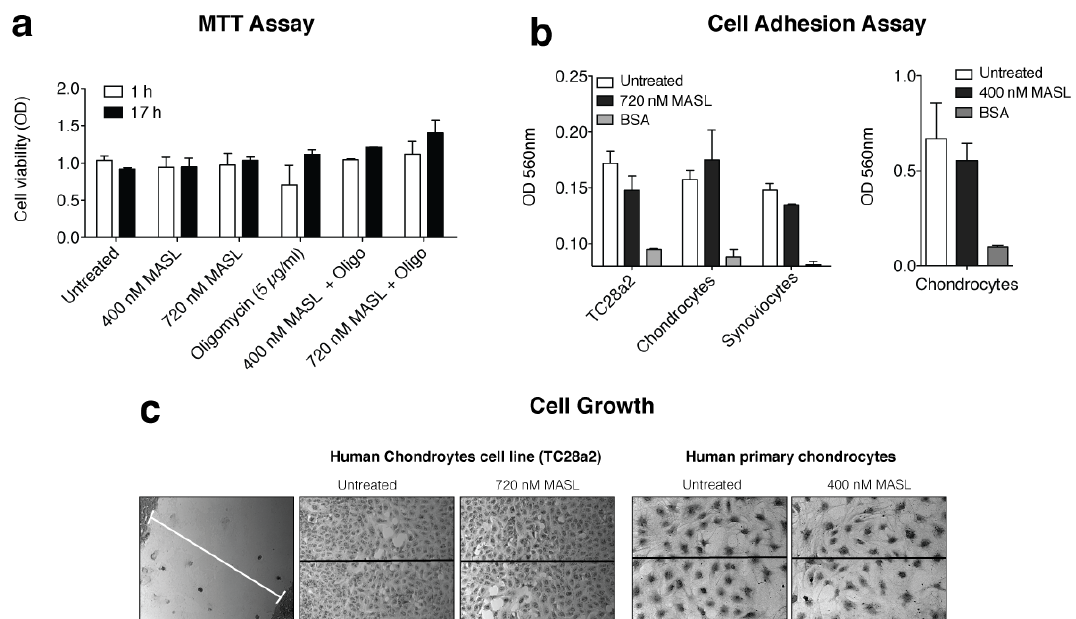
Figure A1. MASL treatment does not affect chondrocyte cell viability, adhesion, growth, or migration. ( a ) Cells from osteoarthritis patients were cultured for 1 or 17 h with 0, 400, and 720 nM MASL with or without 5 µg/mL of oligomycin as indicated. Cytotoxicity was evaluated with the colorimetric MTT assay, and the data are presented as the mean ± SD (n = 2). ( b ) Confluent monolayers of primary human chondrocytes, TC28a2 cells (a human chondrocyte cell line), and primary human synoviocytes were treated for 1 h with varying concentrations of MASL as indicated. Cell adhesion was evaluated with fibrinogen-coated plates, with BSA-coated plates used as controls. The data are shown as the mean ± SD (n = 2). ( c ) Chondrocytes were grown to confluence in wells containing an insert that forms a 0.9 mm gap in the monolayer. After the insert was removed, the cells were treated for 24 h (TC28a2 cells) with 400 or 720 nM MASL or 10 days (primary chondrocytes) and imaged under an inverted light microscope. No differences in cell adhesion or growth were observed between untreated and treated samples (n = 4). Table A1. Leucoagglutinin (MAL) and haemagglutinin (MAH) sequences alignment. The alignment between the MAL and MAH sequences has been performed with the T-Coffee web server [82]. The residue differences between the two sequences have been highlighted in orange, indicating a high sequence similarity. Some key amino acids mentioned in the text are highlighted in blue (MAL: Asn110, Tyr250, Thr252, and Glu253 and MAH: Arg81, Ala219, and Lys221). Importantly, both isolectins share a similar carbohydrate-binding site. Cys272 in MAL has a critical role for homodimerization [83].